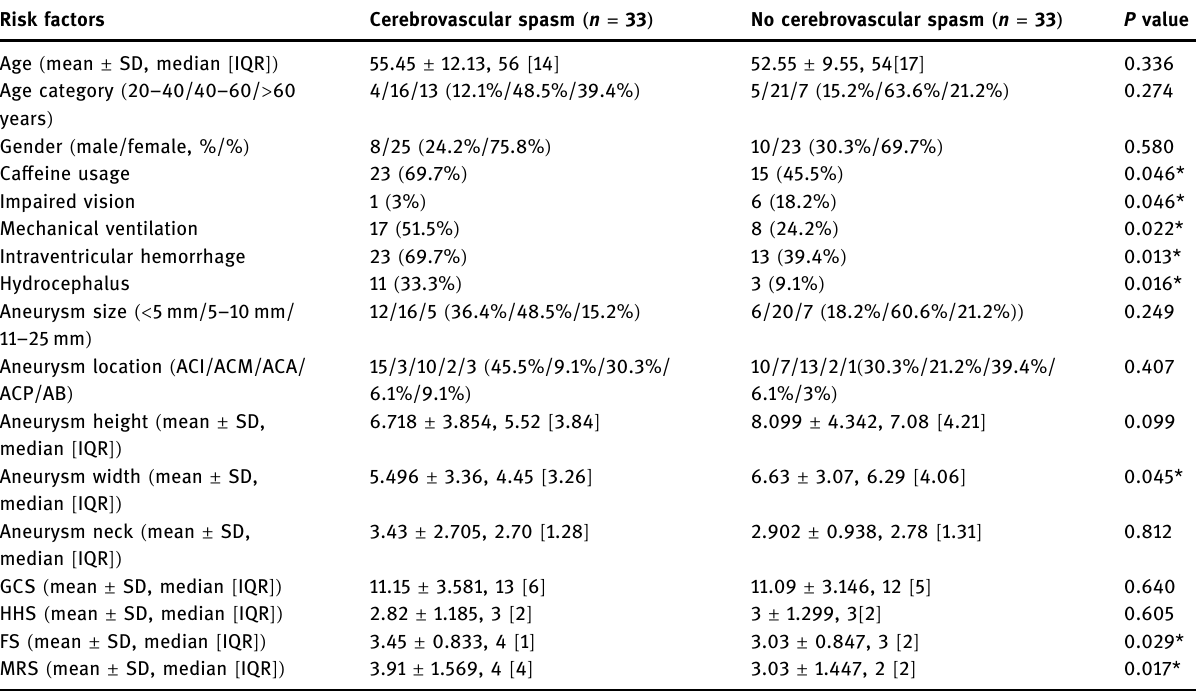
Table 1: Characteristics of the study population Risk